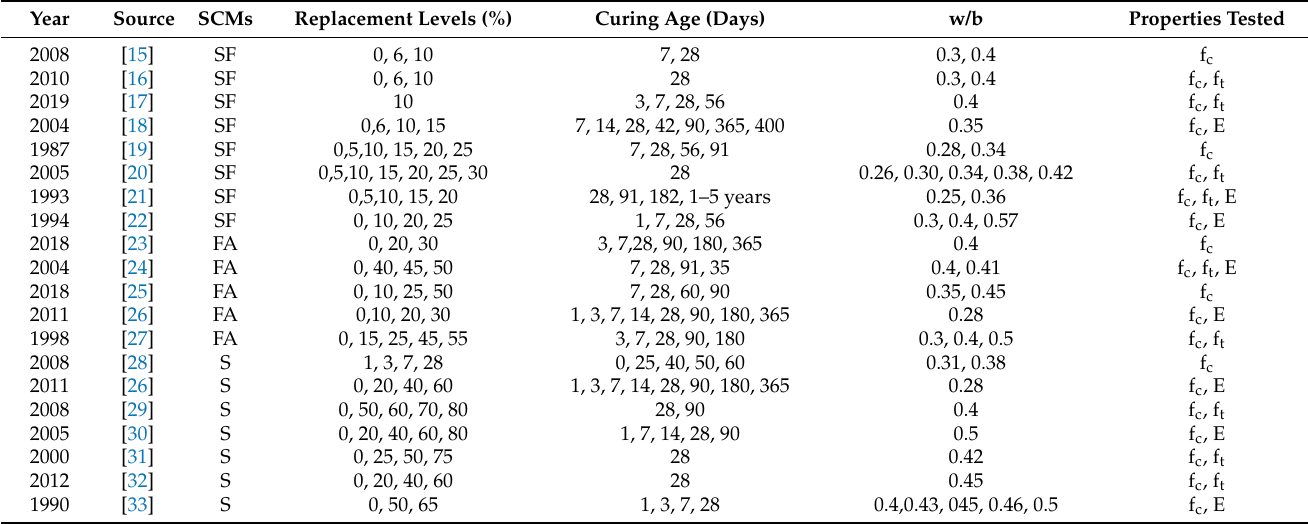
Table 1. Summary of research on the effects of SCMs on concrete at room temperature.